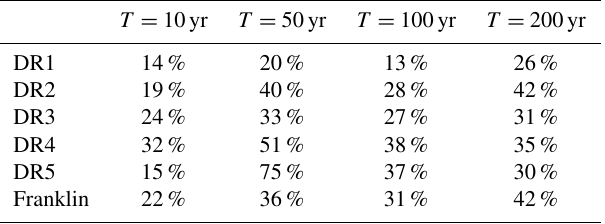
Table 2. The median flood peak reductions using spatially uniform and spatially distributed